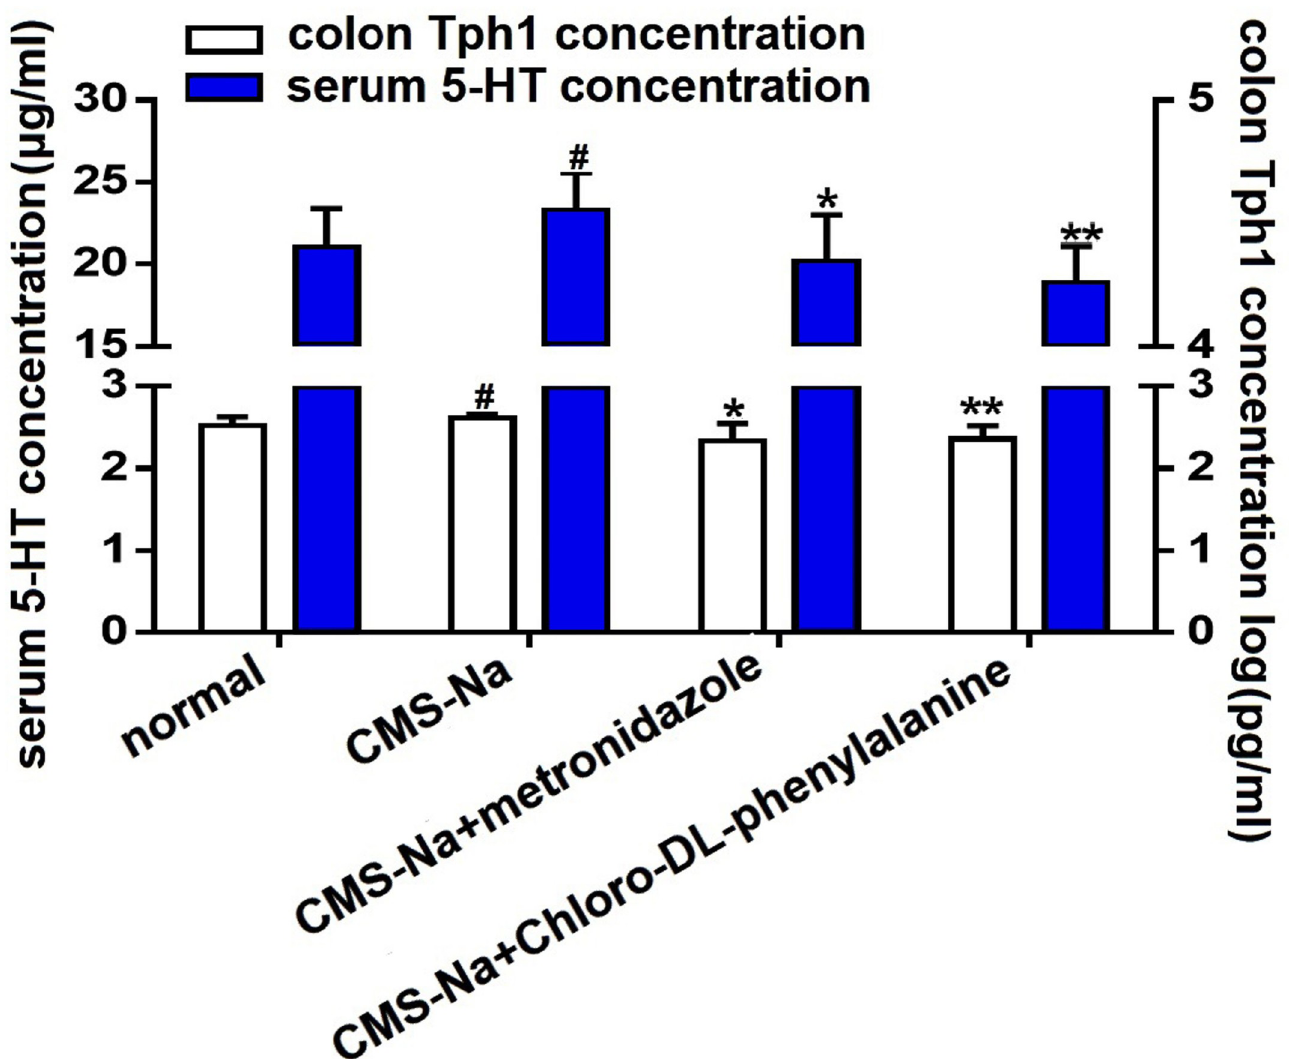
Fig 8. Effect of CMS-Na on tryptophan hydroxylase-1(Thp1) in the colon and 5-hydroxytryptamine(5-HT) in the serum of rats. Rats were orally treated with CMS-Na at a dose of 1.2 g � kg -1 or vehicle once a day for 5 d. Rats blood were collected and the proximal colon (approximately 400 mg) was removed. Determination of Thp1 and 5-HT by ELISA. Mean ± SD, n = 10, � P < 0.05, �� P < 0.01, vs. CMS-Na group. # P < 0.05, vs. normal.